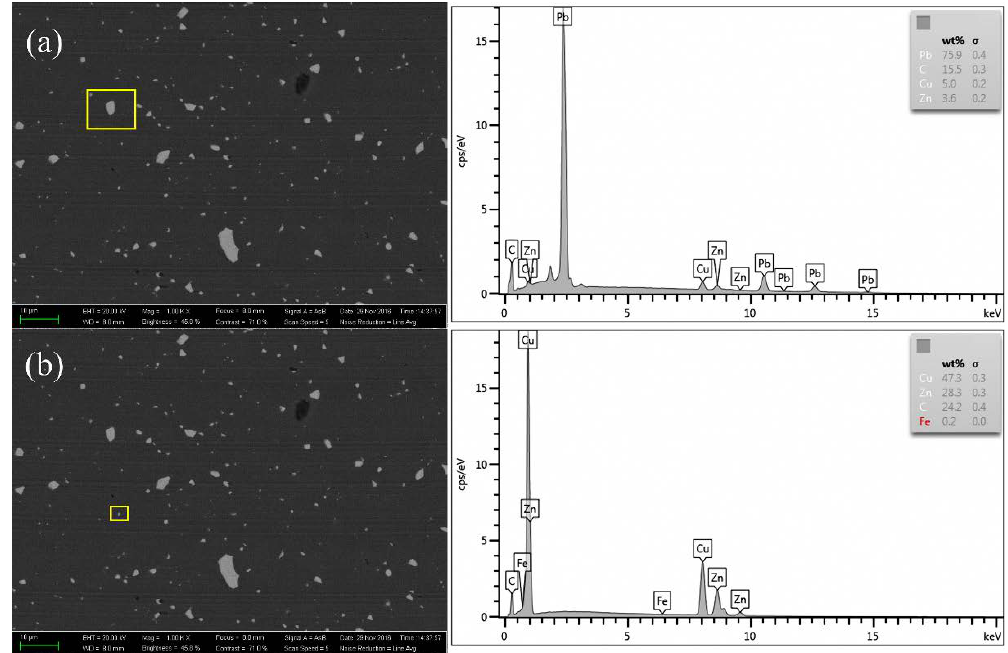
Figure 18. BSEM image and EDS results of the machined Cu alloys. Here, ( a ) and ( b ) are different test positions with different alloy element content.